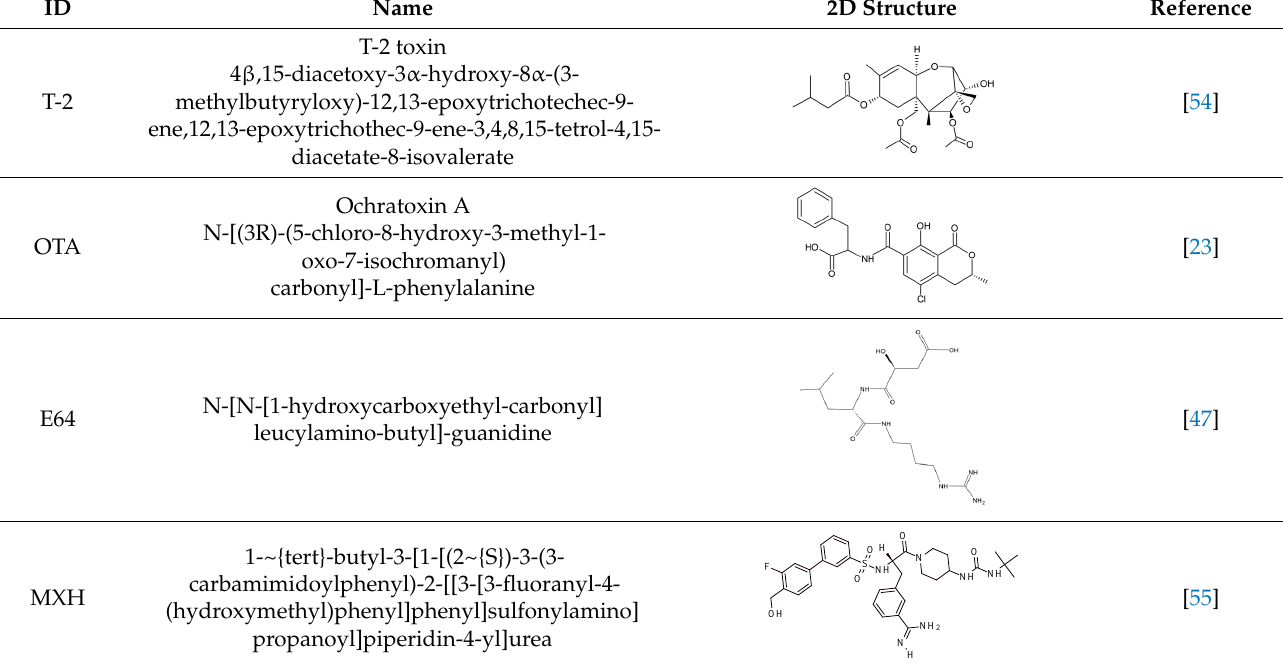
Table 1. Chemical structure of tested and reference